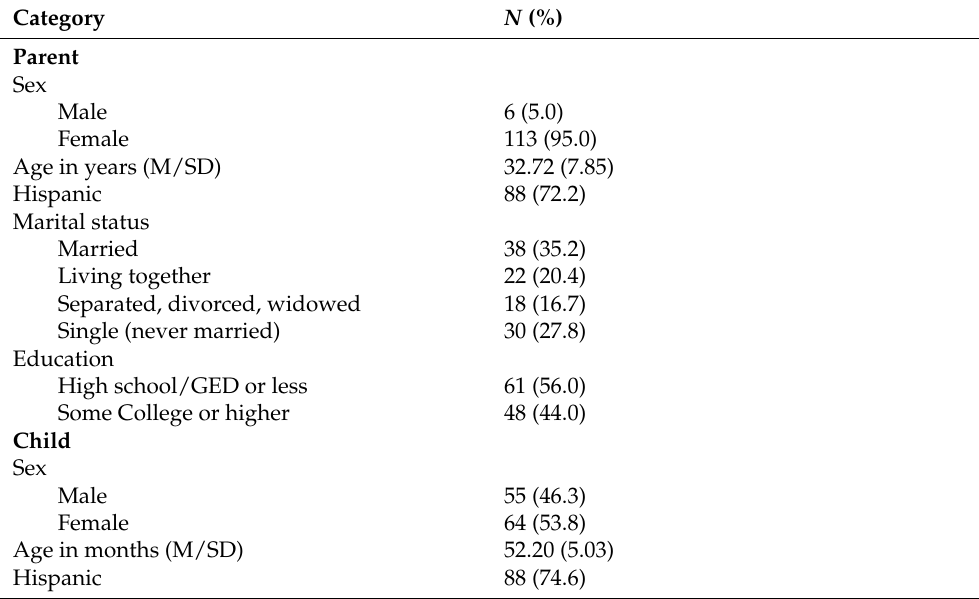
Table 2. Sample characteristics of SAGE participants ( N = 122).